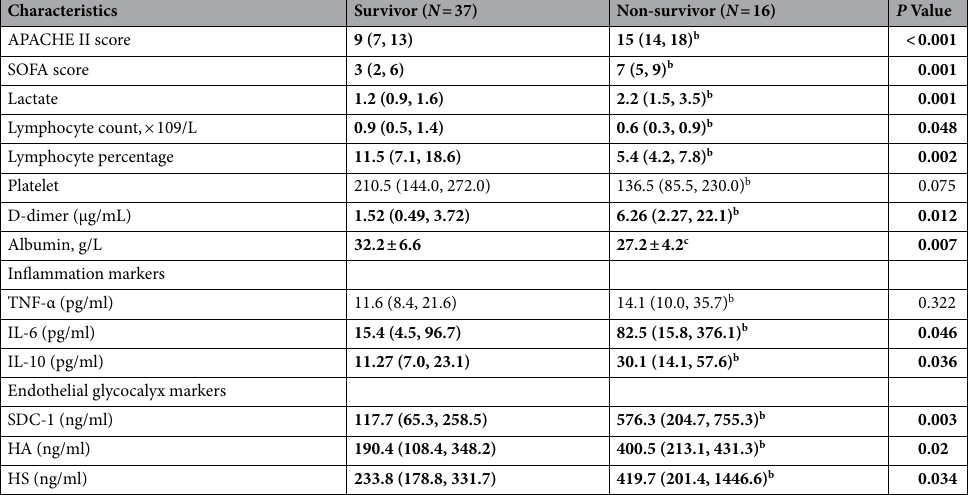
Table 4. The APACHE II and SOFA scores, laboratory records, inflammation markers, and endothelial glycocalyx markers in the survivors and non-survivors (28-day death) on the admission. Data are expressed as median (inter-quartile range), mean ± SD, or number (%). Abbreviations: APACHE, Acute Physiology, Age, Chronic Health Evaluation; SOFA, Sequential organ failure assessment; TNF, tumor necrosis factor; IL-6, interleukin-6; IL-10, interleukin-10; SDC-1, syndecan-1; HS, heparan sulfate; HA, hyaluronan. b , vs. Mild group, Mann – Whitney U test; c , unpaired Student t test.